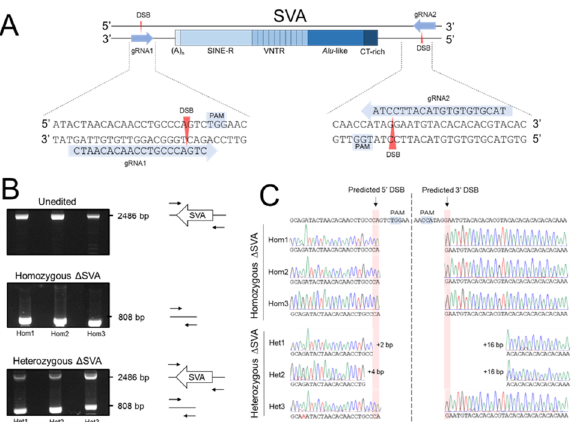
Figure 3. Generation of clonal cell lines containing knockout of entire SVA sequence. ( A ) Schematic of dual-gRNA strategy designed to delete entire SVA sequence. gRNAs were designed to anneal to short 20 bp sequences upstream of protospacer adjacent motif (PAM) sites (5 (cid:48) -NGG-3 (cid:48) ) situated on either side of the SVA. Cas9 generates double strand breaks 3–4 bp upstream of the PAM sequence. The SVA is then excised before the two ends are repaired typically by NHEJ, resulting in deletion of the SVA. Schematic not to scale. ( B ) PCR screening showing isolation of several homozygous ∆ SVA clones with all SVAs deleted and heterozygous ∆ SVA clones demonstrating presence and absence of SVA alleles. ( C ) Sequencing analysis across breakpoints in PCR